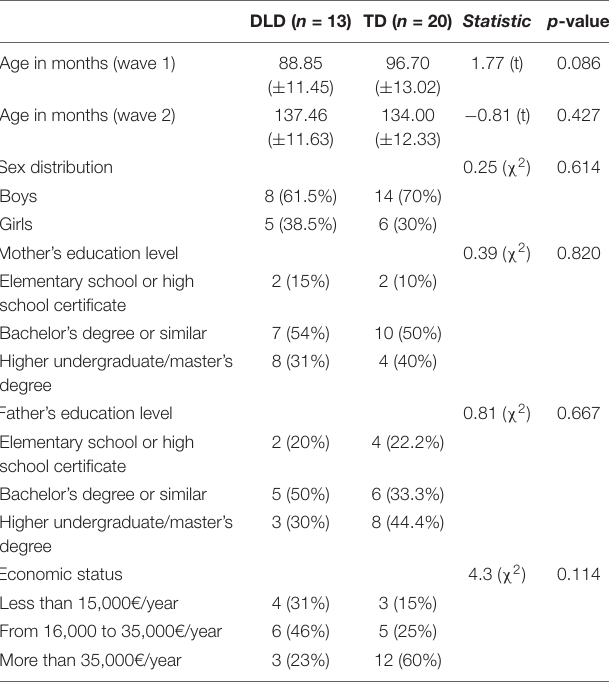
Table 2 . Non-verbal IQ was within normal limits in both